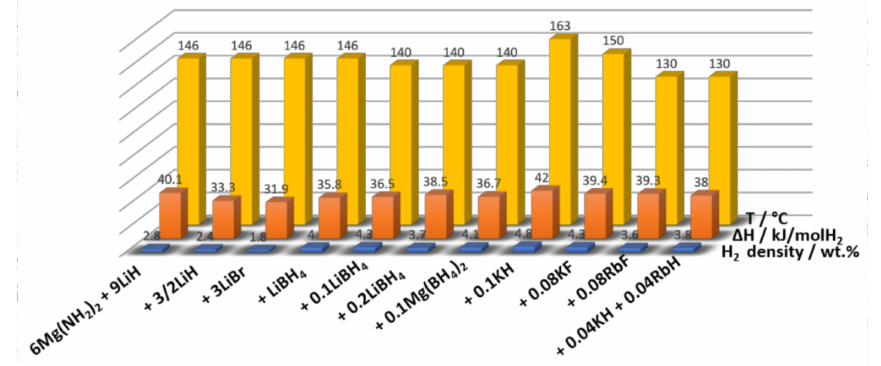
Figure 10. Experimental thermodynamic and kinetic data for the un-doped and doped Mg(NH 2 ) 2 + 2LiH